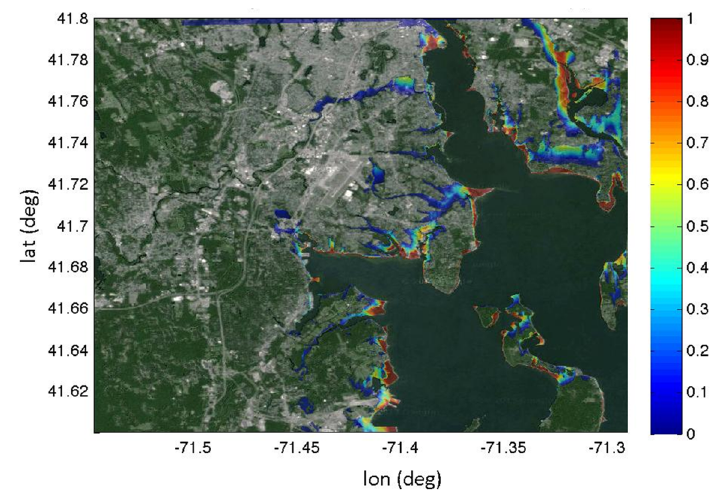
Figure 13. Inundation depths (m) relative to grade for Warwick, RI for 100 year event.